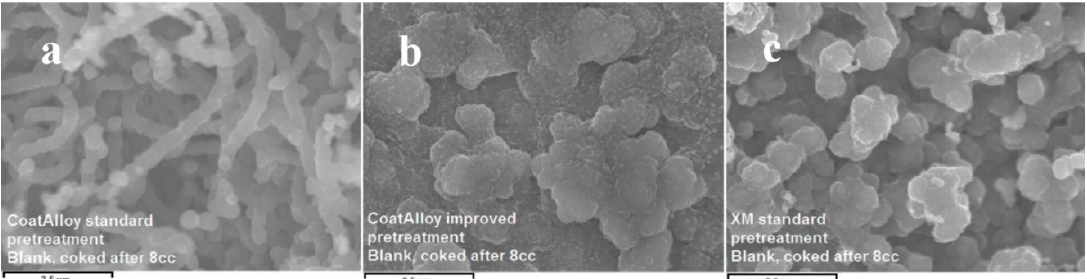
Figure 7. After 8 cracking cycles (cc): coked CoatAlloy™ after the standard treatment ( a ), coked CoatAlloy™ after the steam/air only treatment ( b ) and coked 25/35 Cr/Ni after a standard treatment ( c ). Magnification: 15000 ×, Accelerating Voltage: 10 kV .